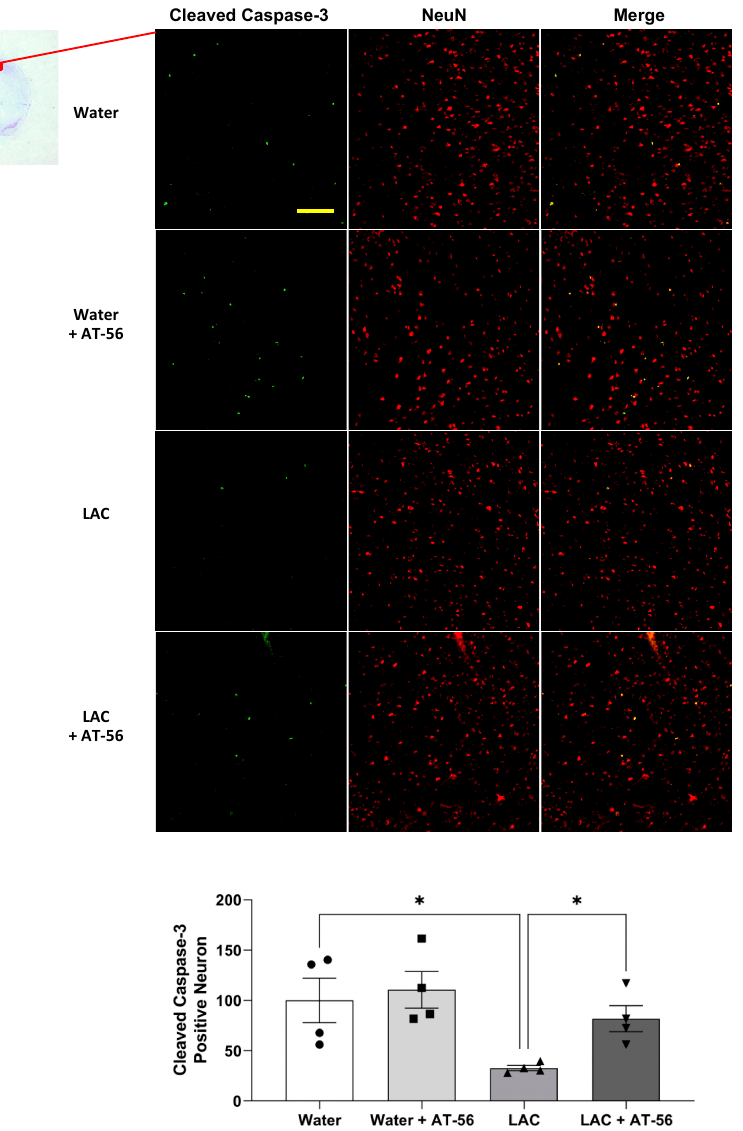
Figure 6. Effect of AT-56 on cleaved caspase-3-positive neurons in the cerebral cortex following transient focal cerebral ischemia. ( A ) Representative double staining of NeuN and cleaved caspase-3 in the peri-infarct cortex of the parietal lobe at the section 0.23 mm caudal to bregma. Scale bar = 100 µ m. ( B ) Values of cleaved caspase-3-positive neurons are means ± SEM for 4 mice in each group. * p < 0.05. Analyzed using two-way ANOVA followed by Tukey’s test.